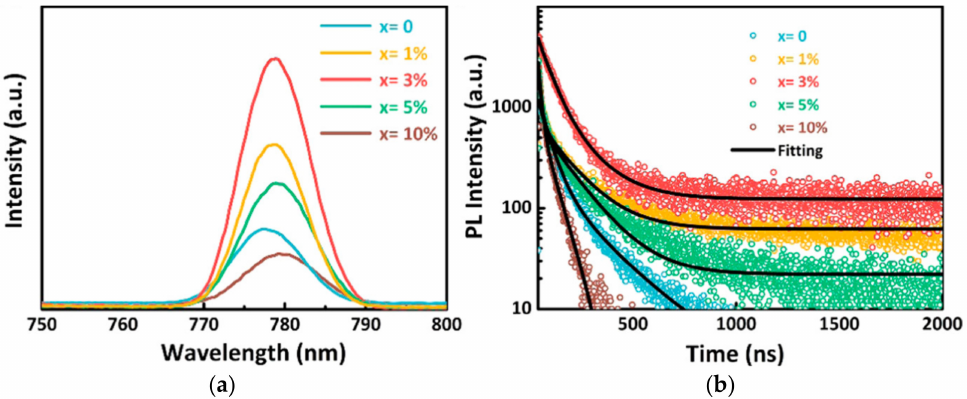
Figure 9. Changes of emission intensity ( a ) as well as emission decays ( b ) as a function of Zn(II) incorporation. MAPbI 3 -based material. MA(Pb:Zn)I 3 -[Cl − ]. The optimum is at 3% for both graphs. Reprinted with permission from ACS Appl. Mater. Interfaces 2017 , 9 , 42875–42882, Reference